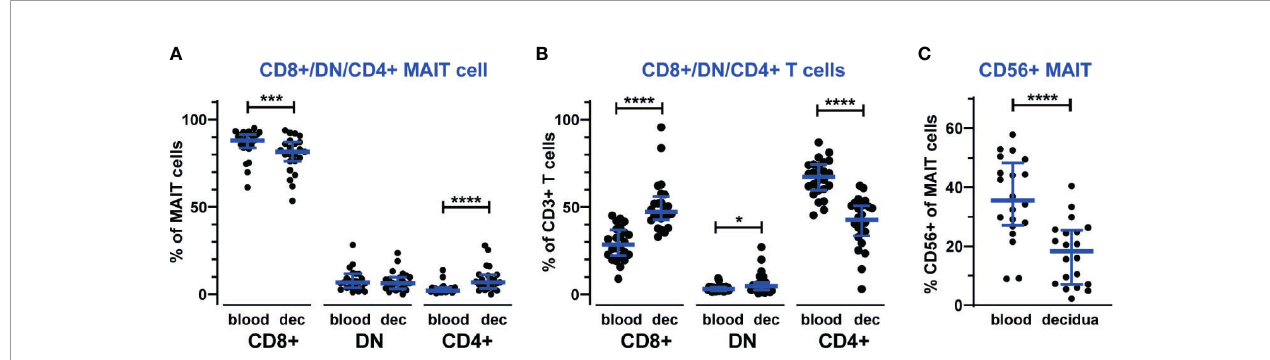
FIGURE 2 | Different composition of MAIT cell subsets in the decidua compared with blood. Proportions of CD8 + , CD4 + and double-negative (DN) subsets of MAIT cells (A) and non-MAIT T cells (B) in blood and decidua (dec). The gating strategy for CD8 + , CD4 + and DN cells is shown in Supplementary Figure S2 . MAIT cells were further analyzed for CD56 expression (C) . Gating of CD56 + MAIT is shown in Supplementary Figure S3 . Bars show median and IQR from 20-24 donors. Statistical comparisons were performed with Wilcoxon signed-rank test. * p < 0.05, *** p < 0.001, **** p <